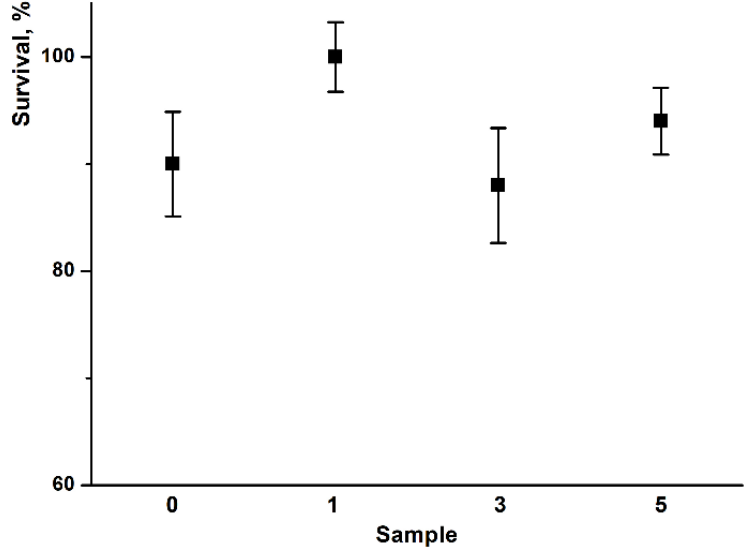
Figure 10. Survival of BJ-5ta cells after 72 h incubation with the PHB with different content of the hemin (0 — 0% wt., 1 — 1% wt., 3 — 3% wt., and 5 — 5% wt). (mean ± SD, n = 3).